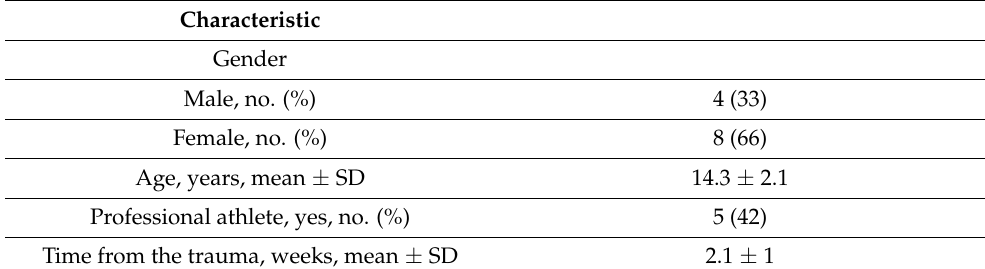
Table 2. Demographic data and patient characteristics.